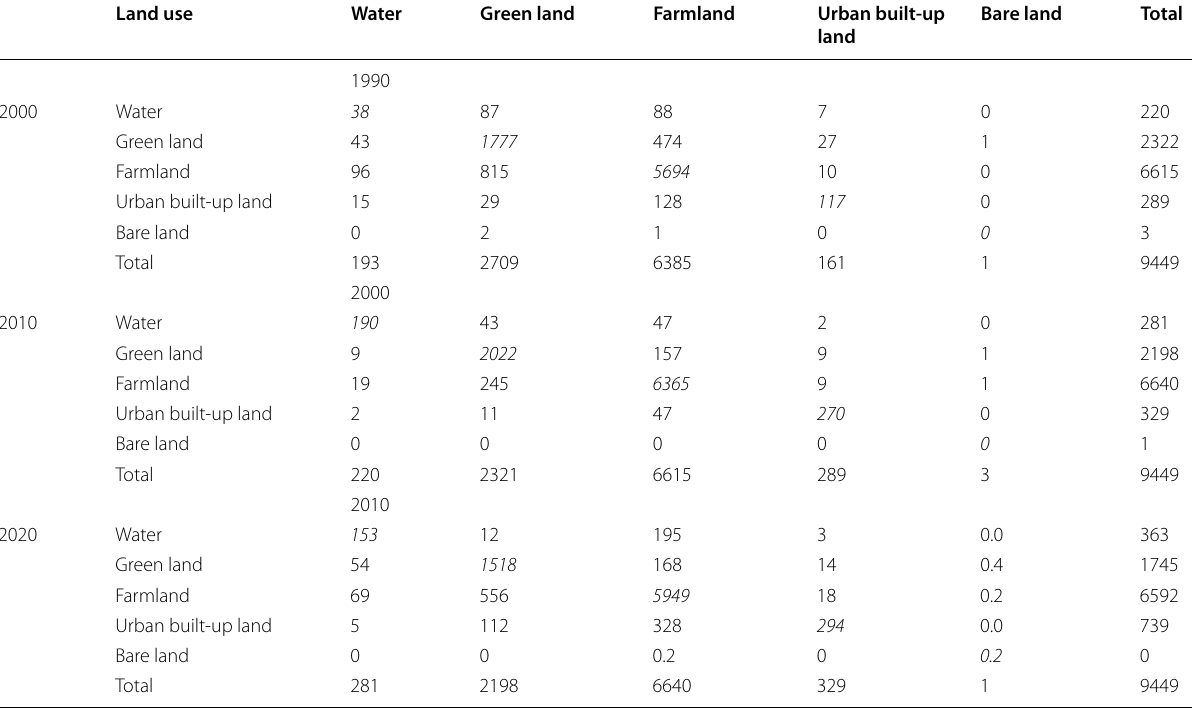
The number in each cell indicates how much (A) type of land in Year I (column heading) was converted to (B) type of land in Year II (row heading). For instance, of the cell (1990 Farmland, 2000 Urban land), the number is 128, which means 128 km 2 of land was converted from farmland to urban area from 1990 to